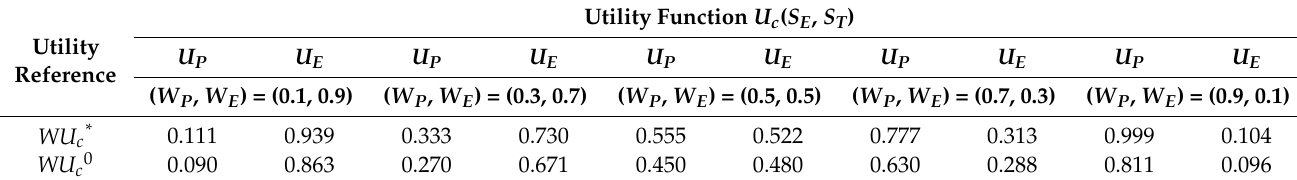
Table 12. Positive and negative ideal reference vectors of the